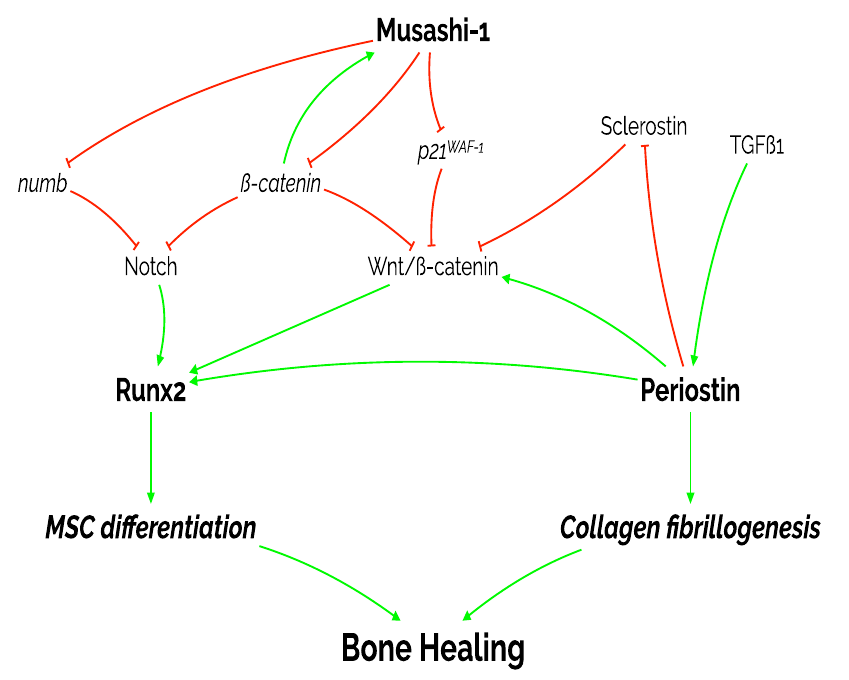
Figure 11. Diagram representing the proposed actions of the three molecules under study on MSC differentiation, collagen fibrillogenesis and, ultimately, bone healing. As shown in this manuscript, there is a positive and statistically significant correlation between the expression of the three markers: periostin, RUNX2, and musashi-1. MSC: mesenchymal stromal cell; p21 WAF − 1 : cyclin-dependent kinase inhibitor 1; TGFß1: transforming growth factor beta 1.